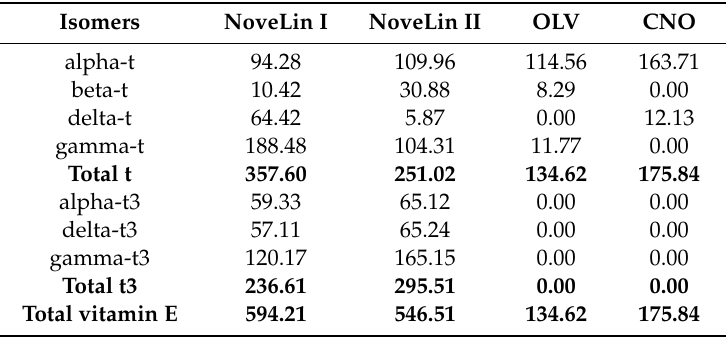
Table 2. Composition of vitamin E components in test diets (ppm).